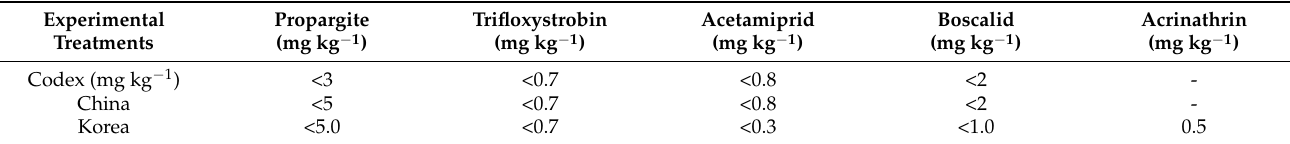
Table 5. Fruit pesticide residues and Japan, European Union (EU), international (Codex), Chinese, and Korean pesticide residue standards.